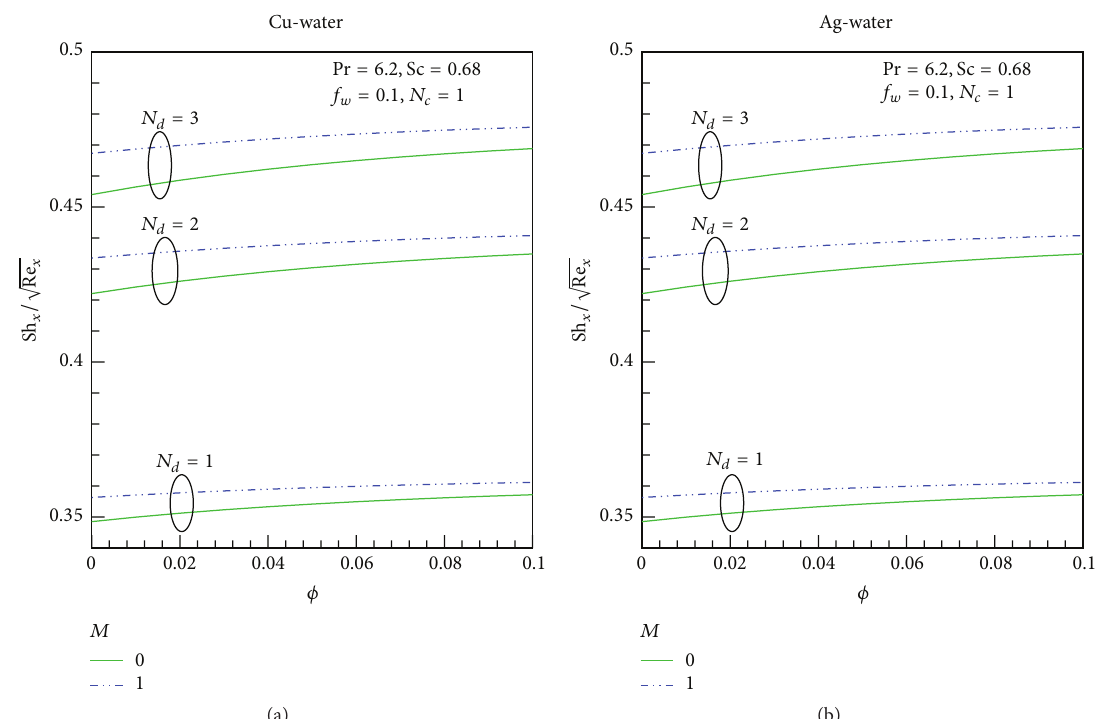
Figure 9: Variation of dimensionless mass transfer rate with 𝑁 𝑑 , 𝑀 , and 𝜙